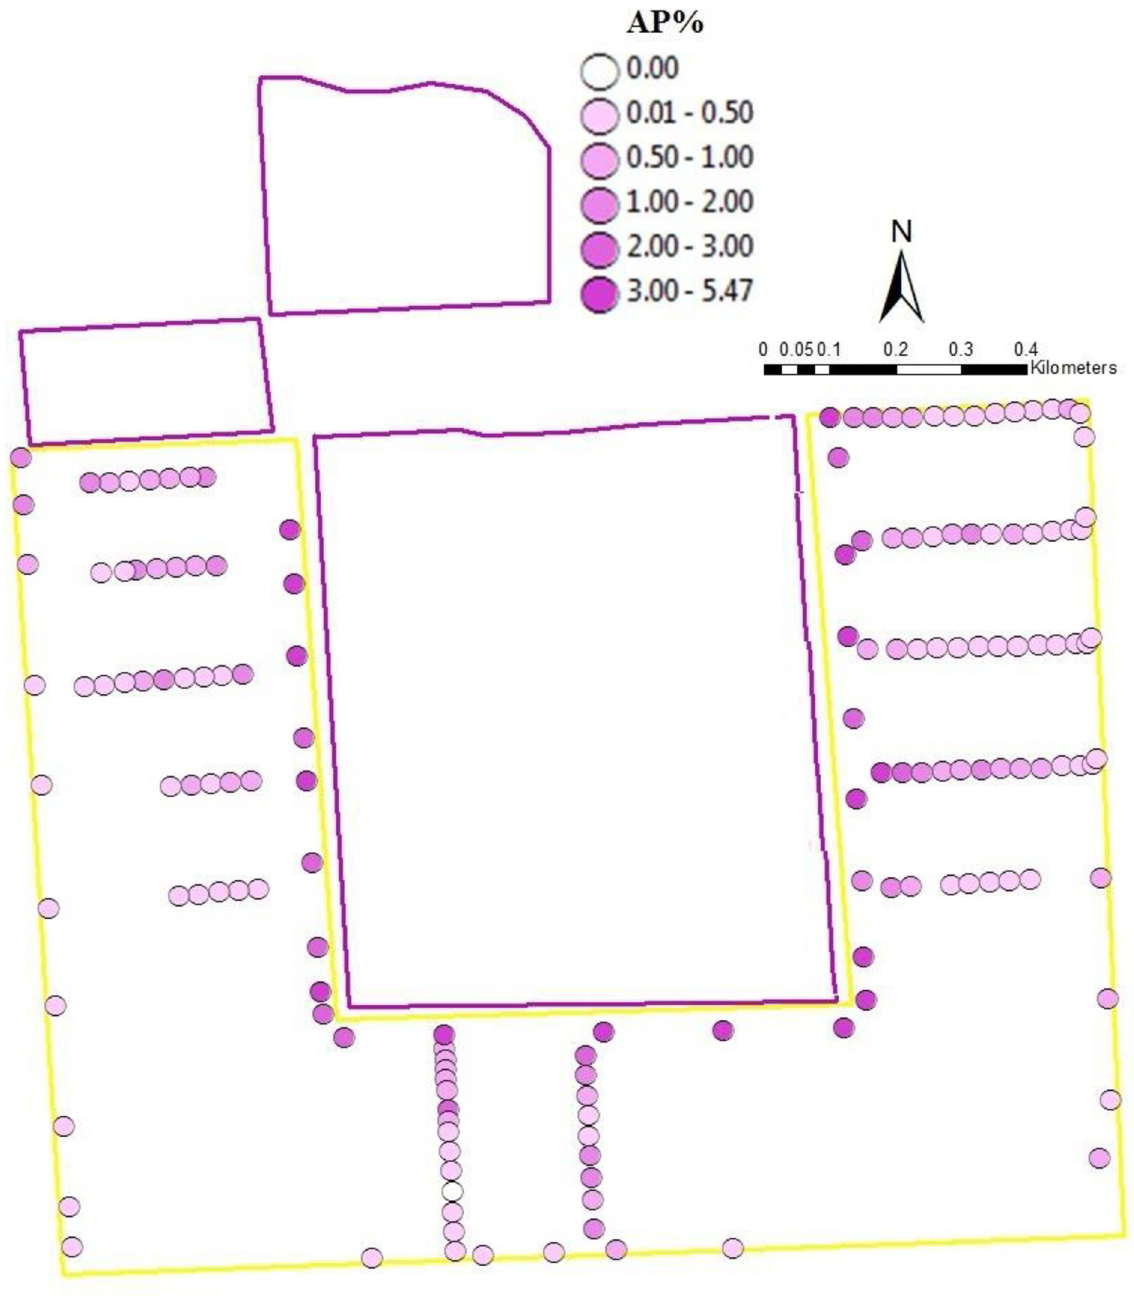
Fig 2. Genetically Engineered (GE) area comparable to conventional area. Adventitious presence (%) in conventional fields (1W, 1S, and 1E) at different distances from GE source field. Yellow outline color represents conventional seed field (right side–Field 1W; left side–Field 1E; bottom–Field 1S); purple outline color represents GE source